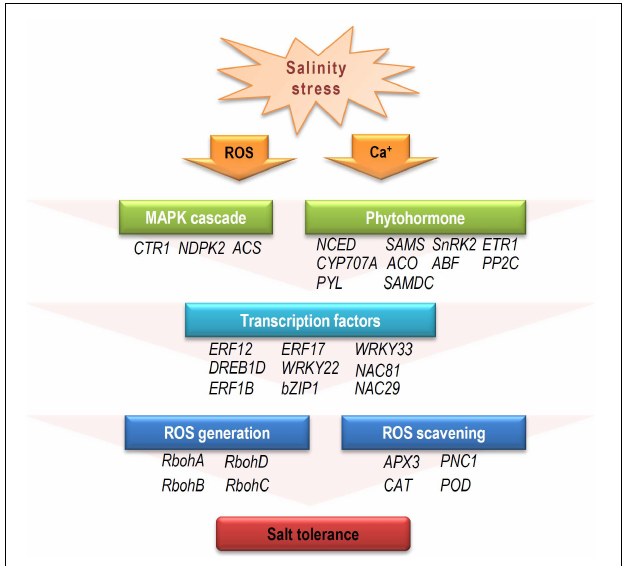
FIGURE 8 | The potential response model to salinity stress in cotton during early developmental stage. When exposed to salinity stress, the resultant stress signal alters secondary messengers, such as calcium (Ca 2 + ), ROS, and stress hormones (ABA and ET). Downstream MAPK cascades influence expression of TFs (e.g., AP2/ERF, MYB, NAC, WRKY, and bZIP) that regulate target gene expression. These target genes are involved in ROS generation and scavenging, leading to varying salinity-stress responses. CTR1, constitutive triple response 1; NDPK2, nucleoside diphosphate kinase 2; ACS, 1-aminocyclopropane-1-carboxylic acid synthase; NCED, 9- cis -epoxycarotenoid dioxygenase; SAMS, s-adenosylmethionine